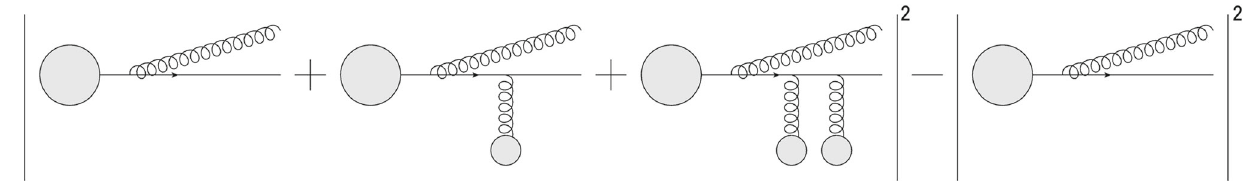
Fig. 6 Schematic depiction of the amplitude squared contributing to the first order in opacity contribution to the single inclusive radiative gluon emission spectrum; the diagrams corresponding to one or more